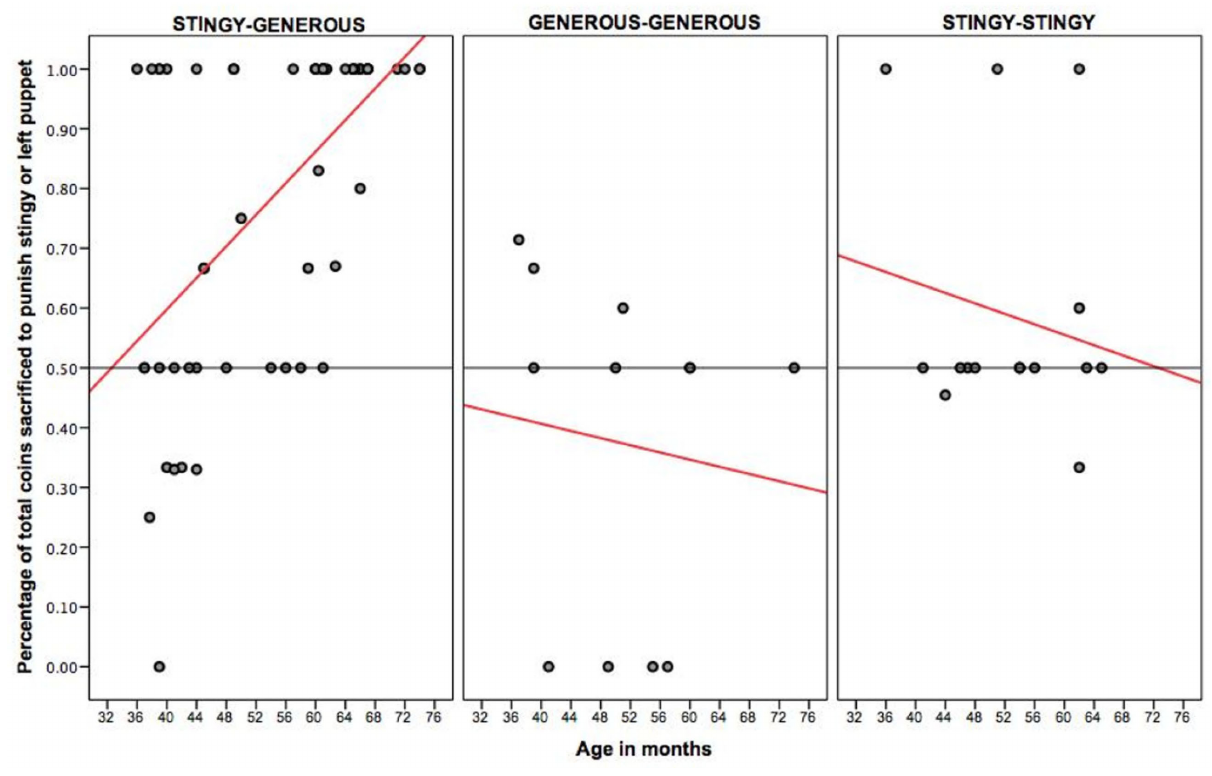
FIGURE 5 | Coins sacrificed to punish during the costly punishment task in Studies 2–4. Vertical axis represents the proportion (%) of the total coins sacrificed by each child to punish the stingy puppet (Study 2, left panel) or the